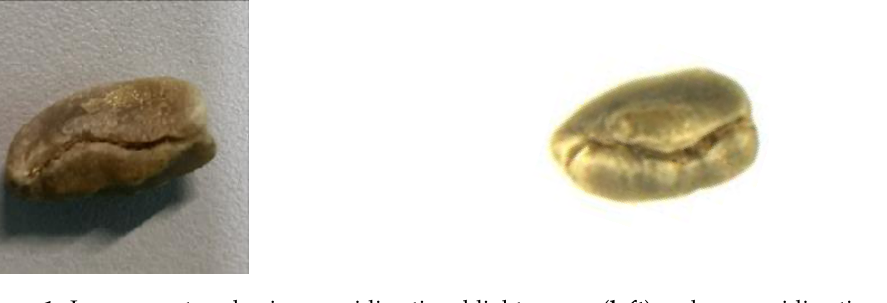
Table 2. Adjusted AlexNet configuration.